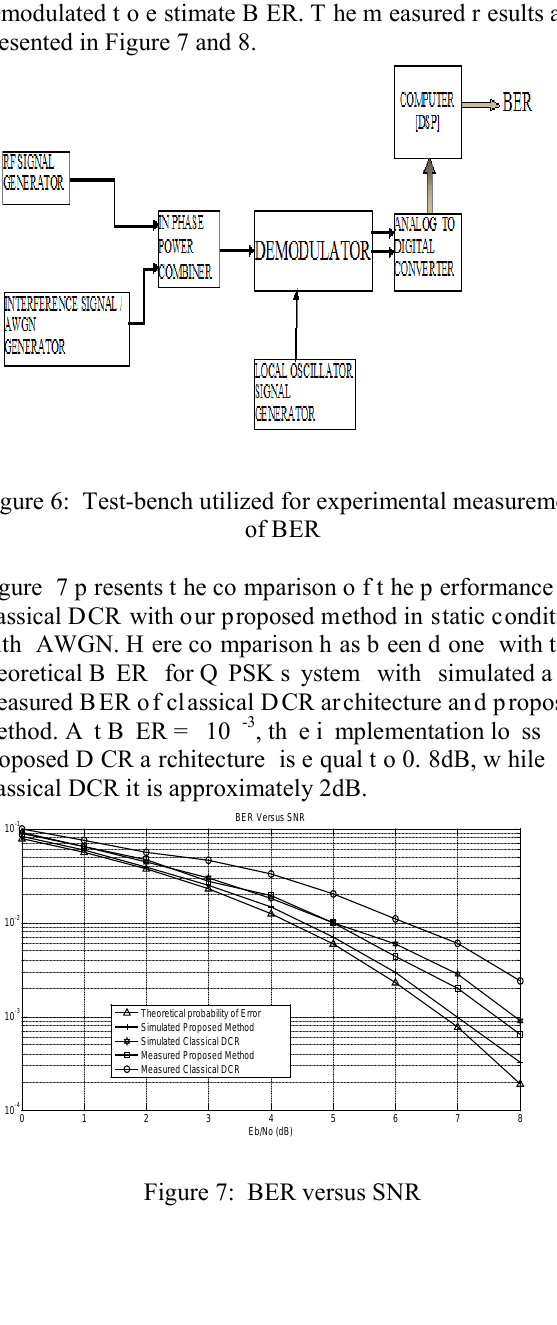
Figure 8: BER versus RF power of